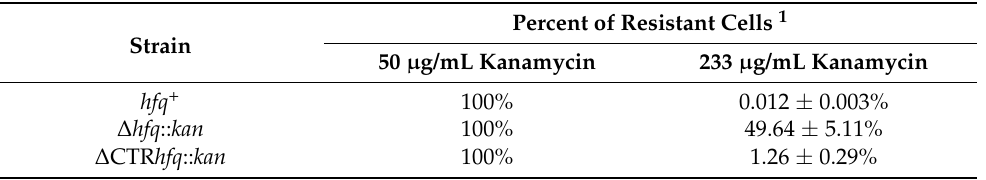
Table 2. Resistance of E. coli hfq + , ∆ hfq :: kan, and ∆ CTR hfq :: kan strains to different concentrations of kanamycin.